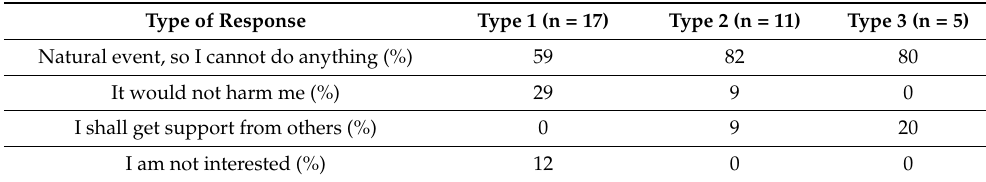
Table 3. Why the respondents did not want to take flood preparedness measures in the study area. Source: